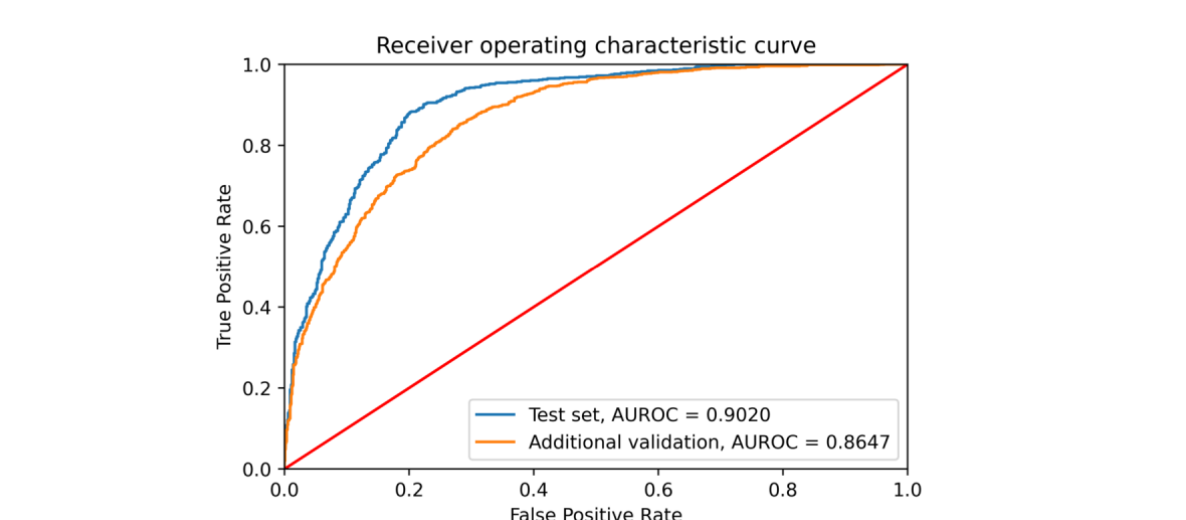
Figure 4. Receiver operating characteristic (ROC) curve illustrating the screening ability of the model. The red line shows a random guess, the blue line is the result of the test set collected in 2018, and the orange line is the result of additional validation using data from 2017. AUROC curve: area under the receiver operating characteristic curve.